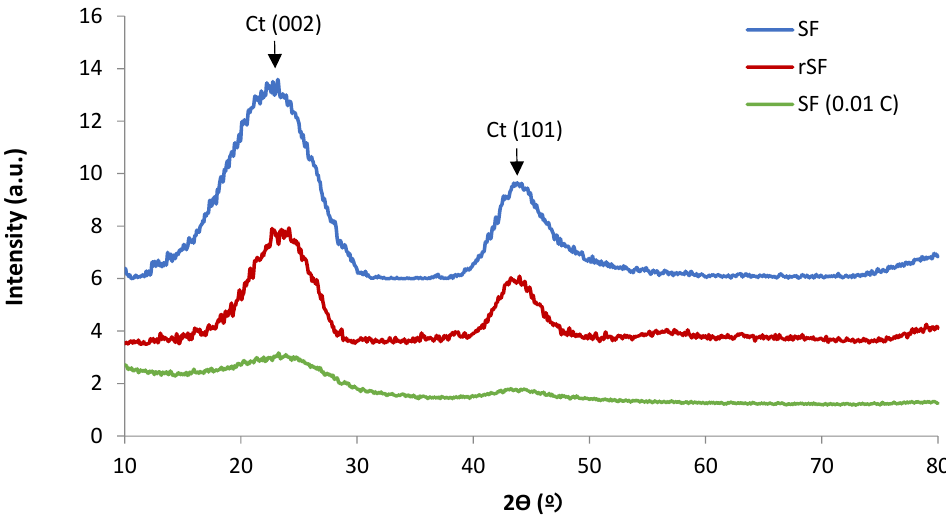
Figure 7. XRD patterns of the carbon foams SF, rSF2 and SF(C). Ct: turbostratic structure.